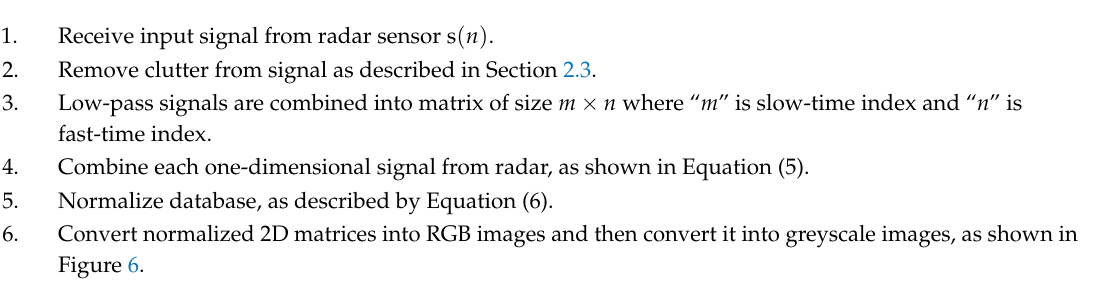
Figure 7. Similarities and differences in 2D gesture data.